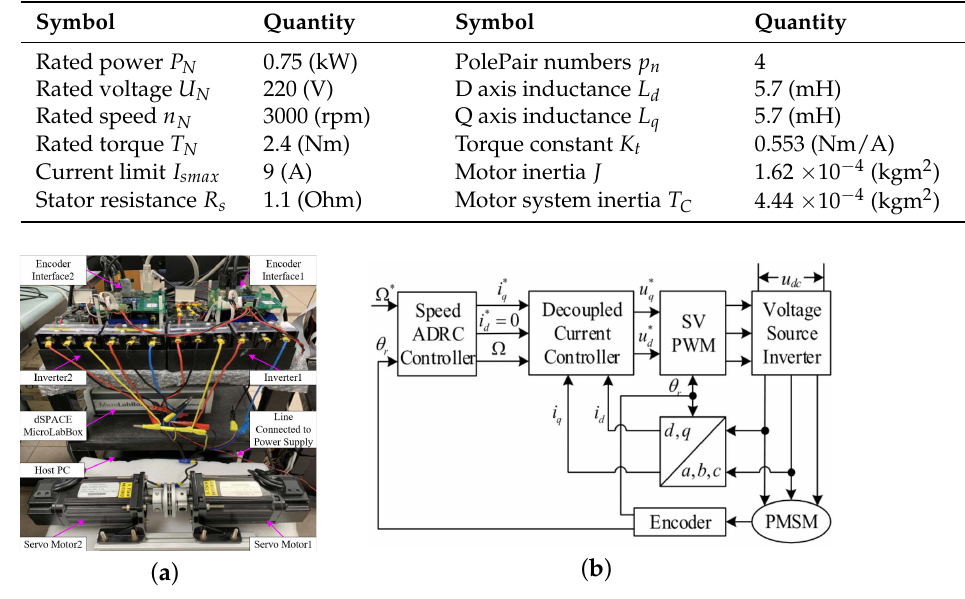
Table 1. Parameters of the tested SPMSM.